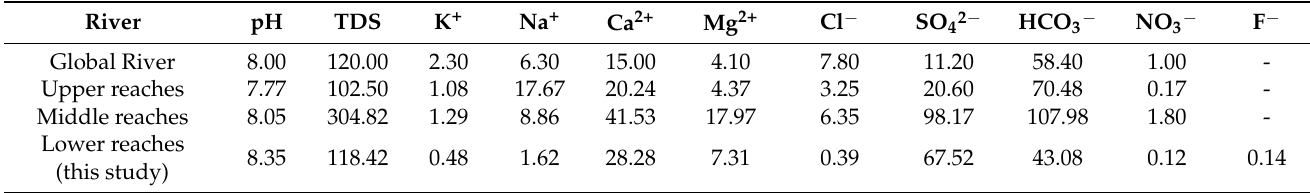
Table 2. Statistics of major ions in the whole basin of Yarlung Tsangpo River